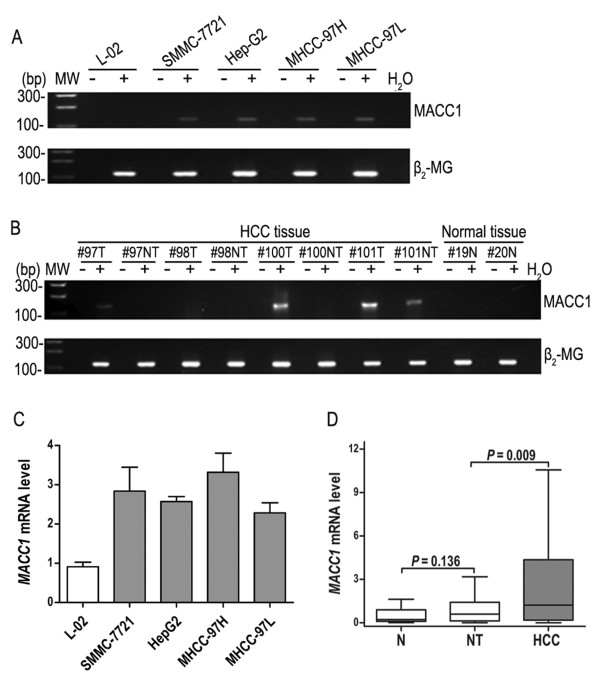
Analysis of MACC1 expression in liver tissues and cell lines. A: MACC1 expression in four human hepatoma cell lines (HepG2, SMMC-7721, MHCC-97H, and MHCC-97L) and one normal liver cell line, L-02, by reverse-transcription PCR (RT-PCR). B: Representative MACC1 mRNA expression in hepatocellular carcinomas (T) and matching non-cancerous (NT) and normal non-cirrhosis (N) liver tissue using RT-PCR. An RT-negative control (-) was added to rule out false positives resulting from contaminated DNA. Products of 136 bp were expected for MACC1 transcripts. C: Comparison of MACC1 expression levels in five liver cell lines, as determined by real-time quantitative-PCR (Q-PCR). D: Comparison of MACC1 expression levels in 20 normal liver tissues (N), and 128 paired HCC with matching non-cancerous (NT) specimens by Q-PCR. The differences among HCC tissues (median 1.632), the adjacent non-cancerous tissues (median 0.601), and normal tissues (median 0.218) are significant (P = 0.009, P = 0.008, respectively), and no significant difference was found between the adjacent non-cancerous and normal tissues (P = 0.136).